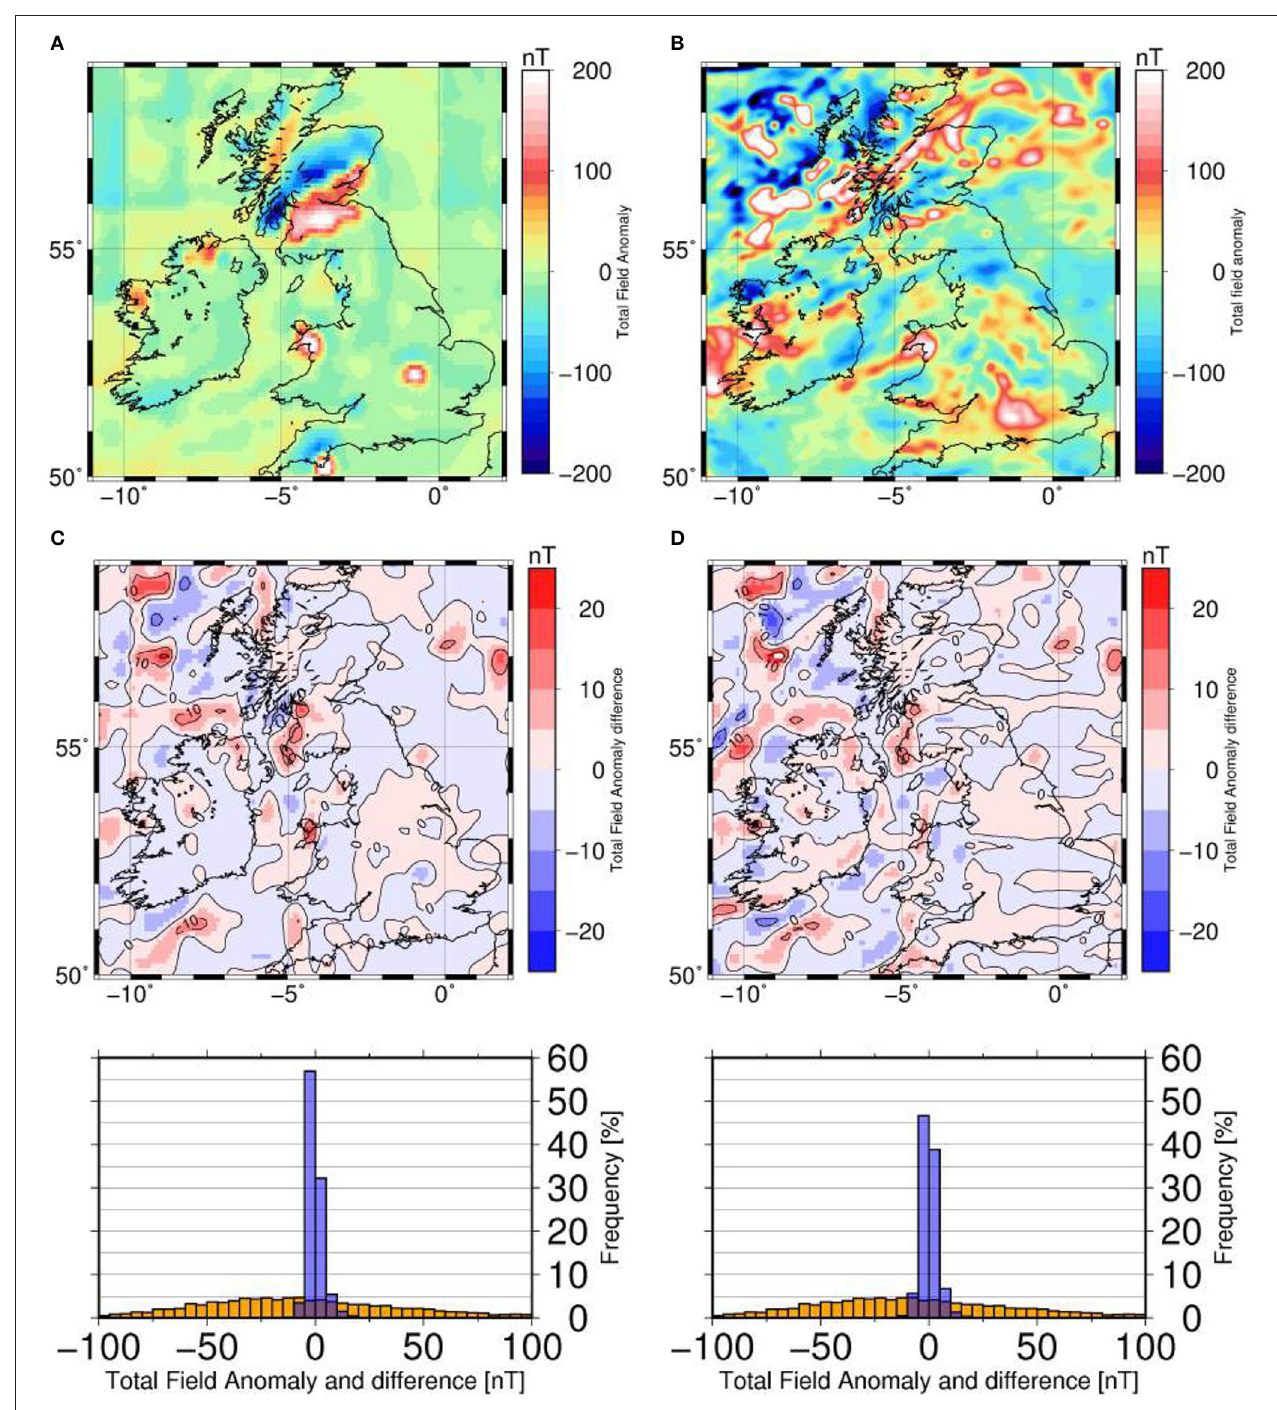
FIGURE 10 | Forward calculated synthetic crustal magnetic field. (A) Forward calculated magnetic field anomaly associated with model M1_s assuming the vertical integrated susceptibility (VIS) derived from Hemant (2003). (B) EMAG-2 V2 Magnetic Anomaly (Maus, 2009). (C) Difference between the calculated magnetic anomaly for model M1_s ( A in this figure) and for a flat model (30 km constant Curie depth) with VIS from Hemant (2003). Underneath: histogram of values in EMAG2 dataset (orange) and in this difference map (blue) (D) Difference between the calculated magnetic anomaly for model M1_s (A) and for model M2_g-elev with VIS from Hemant (2003). Underneath: histogram of values in EMAG2 dataset (orange) and in the difference map (blue).